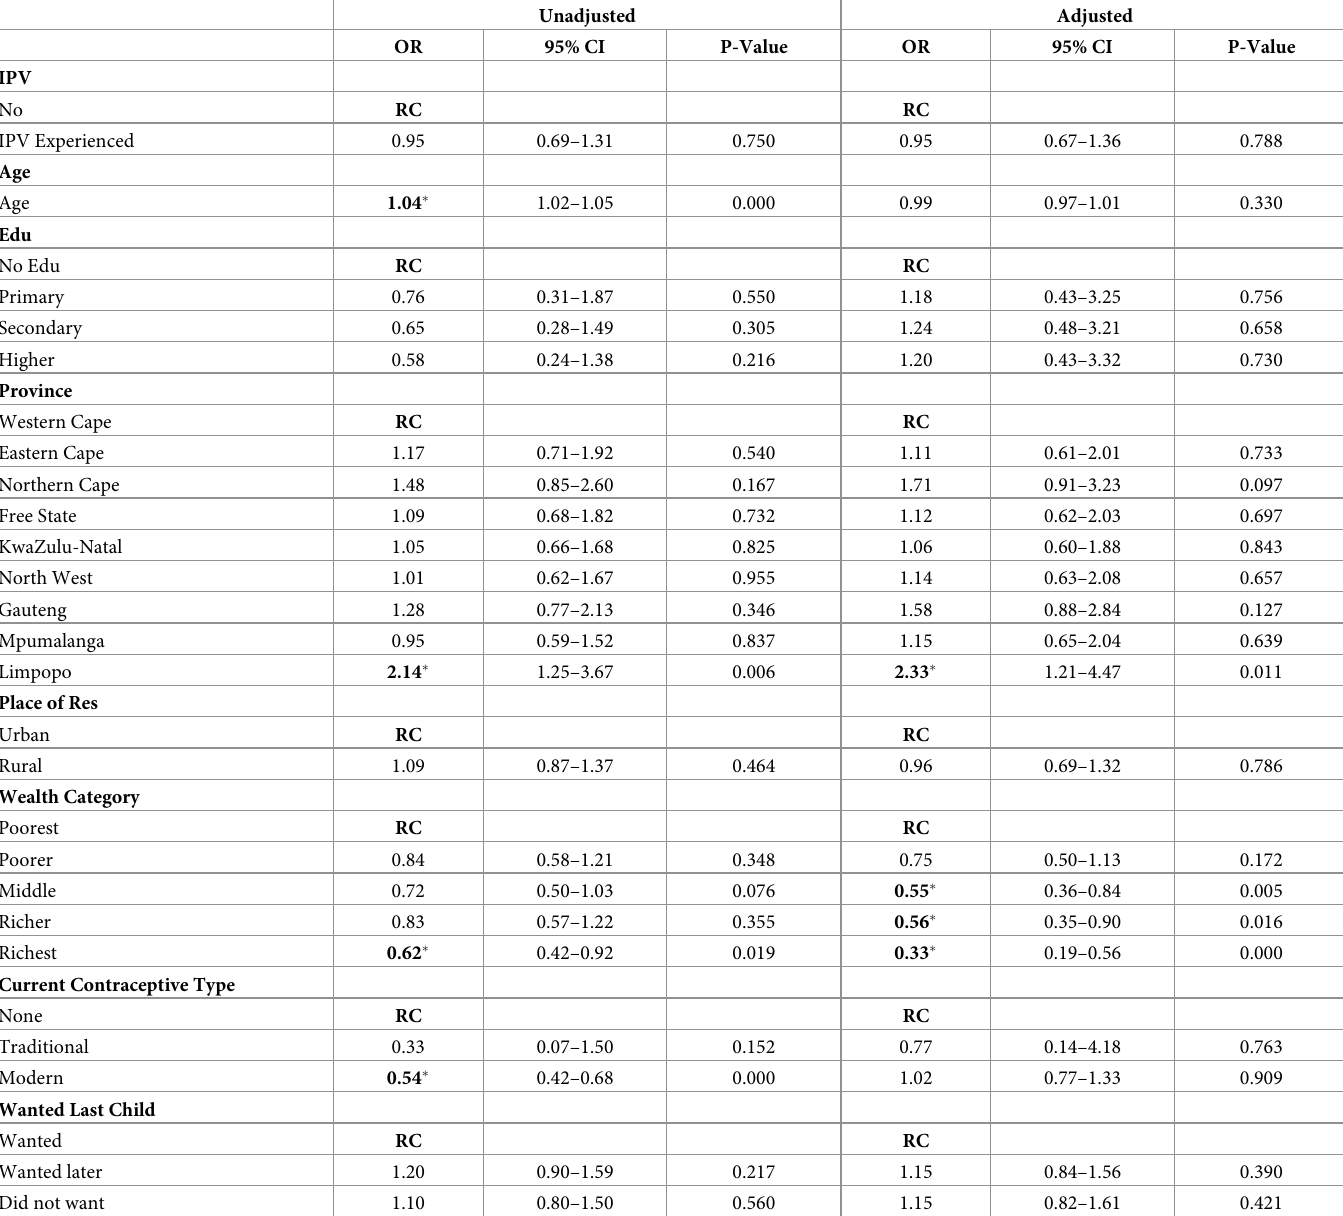
Table 5. Unadjusted and adjusted regression for duration of breastfeeding of last-born child. Unadjusted Adjusted OR 95%